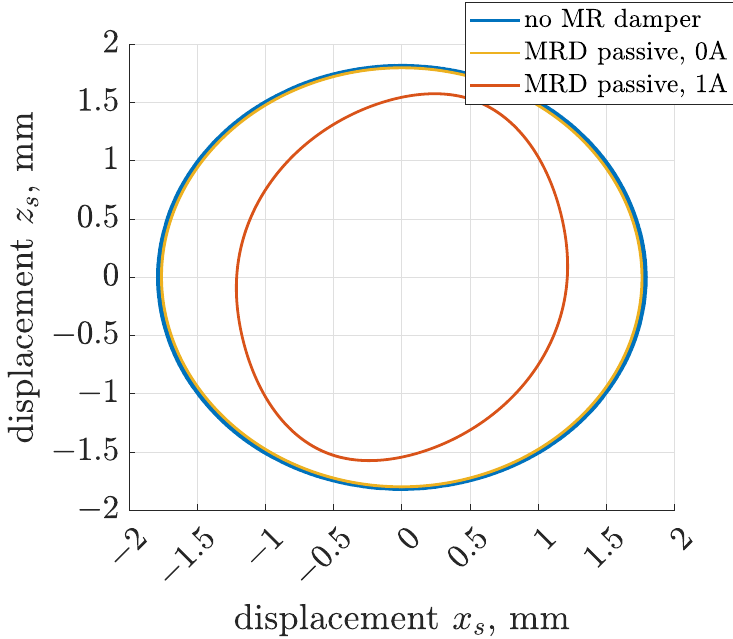
Figure 19. Comparison of trajectories of screen vibration displacement evaluated for the screen model without an MR damper model included and with an MR damper controlled by a constant current equal to 0 or 1